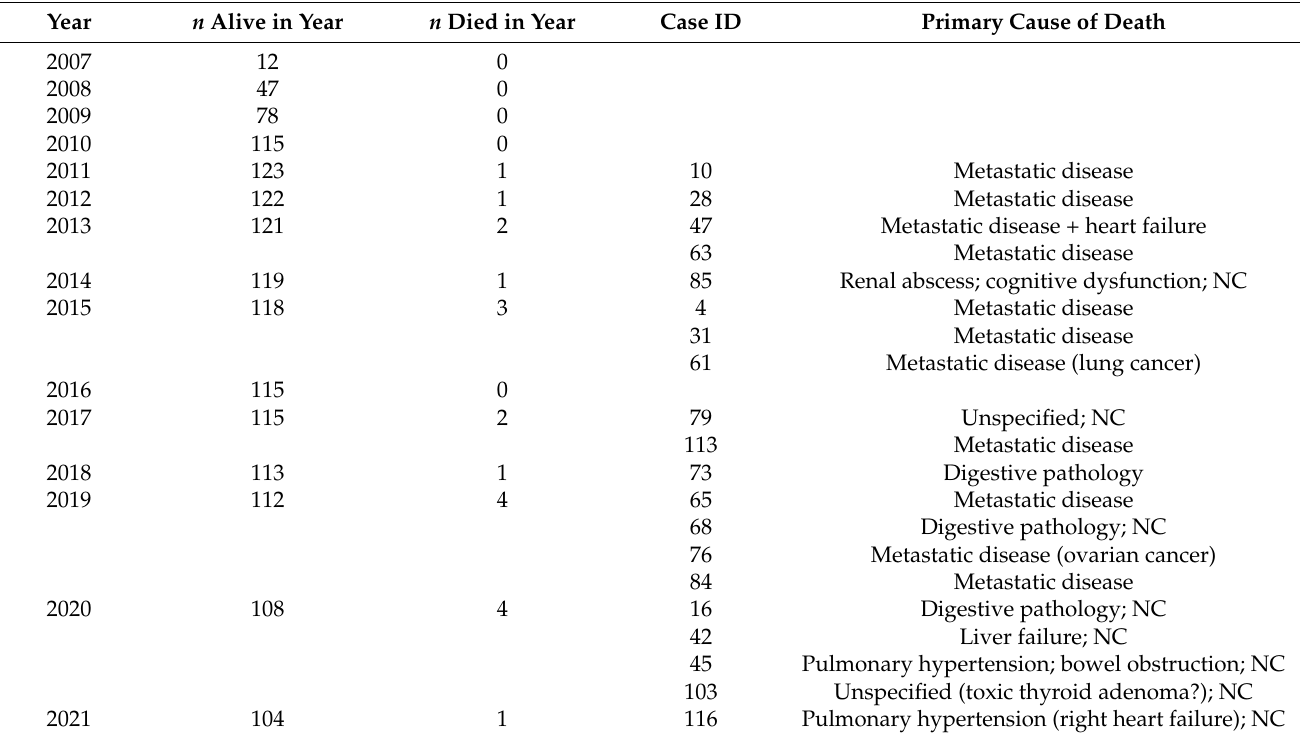
Table 2. Causes of death. NC, no known cancer at time of death. Case ID: reference case number linked to the shared data at https://zenodo.org/deposit/5919956 (accessed on 30 January